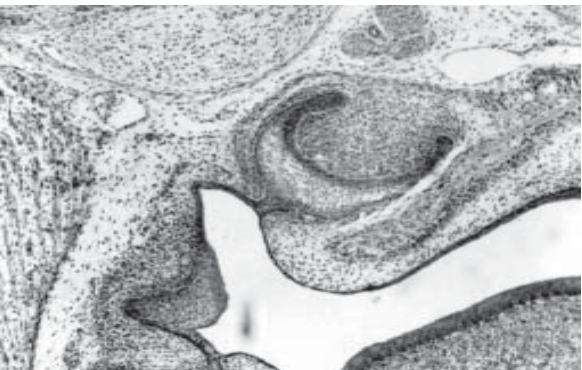
Figure 2 – Control Group – Close palatal processes in the midline and formation of bone trabeculae. H&E. Magnification: 125X.